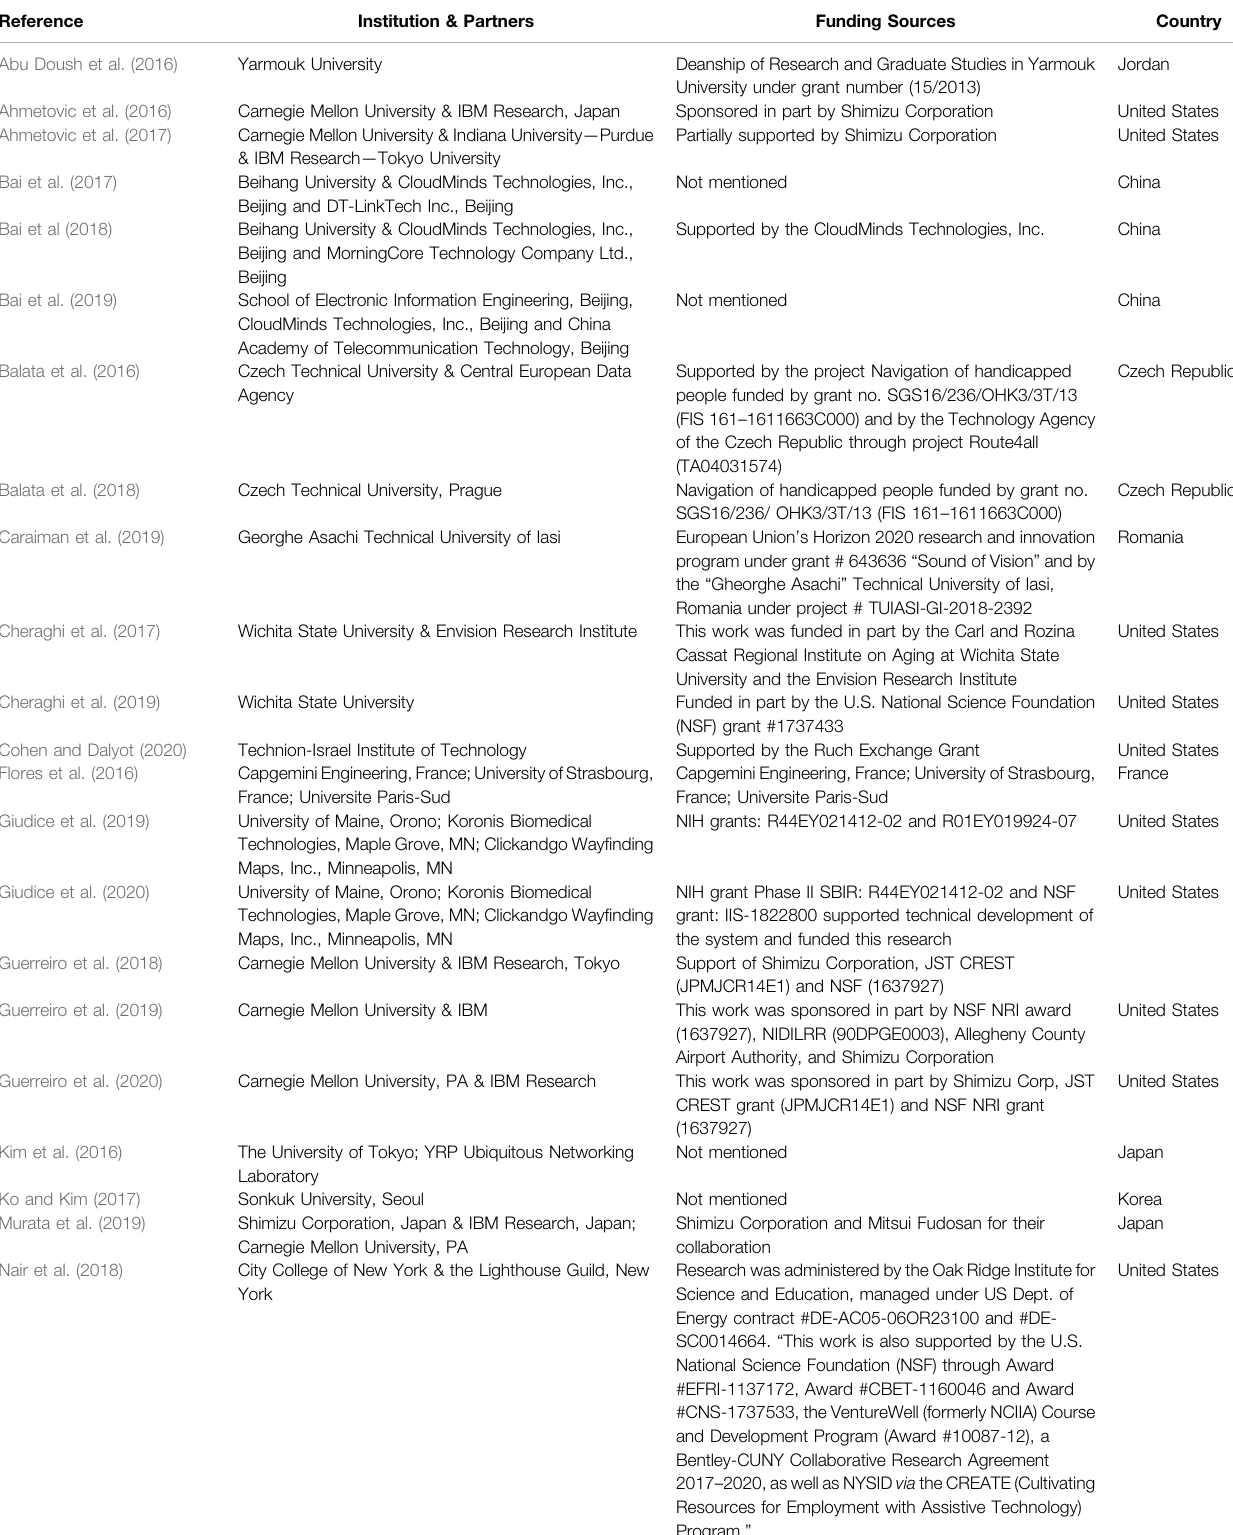
TABLE 4 | Research institutions and fi nancial